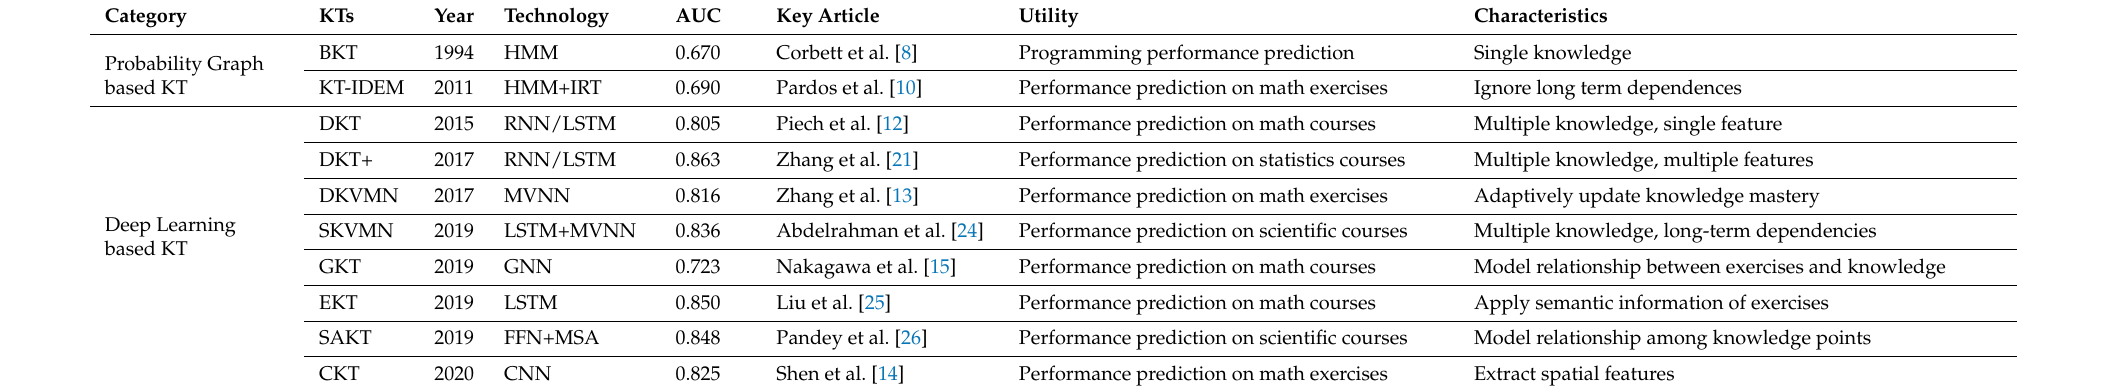
Table 1. Comparison of previous main research in KT. The “Category” column represents the two main types of knowledge tracing methods, the “KTs” column stands for the different knowledge tracing models, the “Year” column is the year that the knowledge tracing model was firstly published, the “Technology” column means the main machine learning or deep learning techniques used, the “Key Article” column shows the key articles involved in the method, the “Utility” column serves as the educational application scenarios, and the “Characteristics” column summarizes the main features of the knowledge tracing